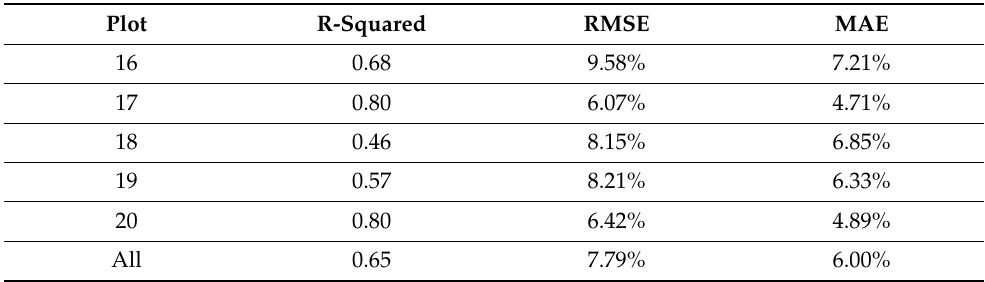
Figure 7. Field-measured LFMC_WAS versus predicted LFMC_WAS using MLR model ( top ) and AdMLR model ( below ) using all plots and dates in the sample. The regression line is drawn as a continuous line, and its equation is in the title of each graph. Table 6. Root mean square error (RMSE), mean absolute error (MAE), and the square of Pearson’s correlation coefficient (R-squared) between observed and predicted LFMC_WAS in validation plots given in Table 2. Model (5) was used for prediction of